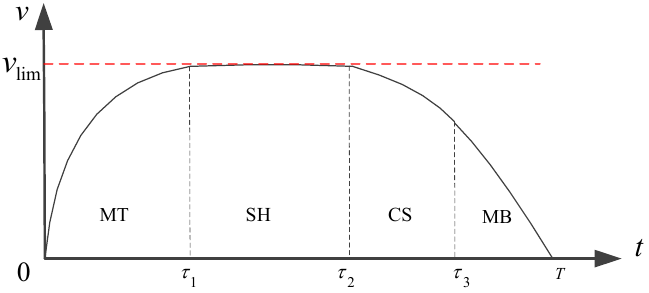
Figure 2. Optimal driving regimes for energy-efficient driving on a level track as a function of time with switching